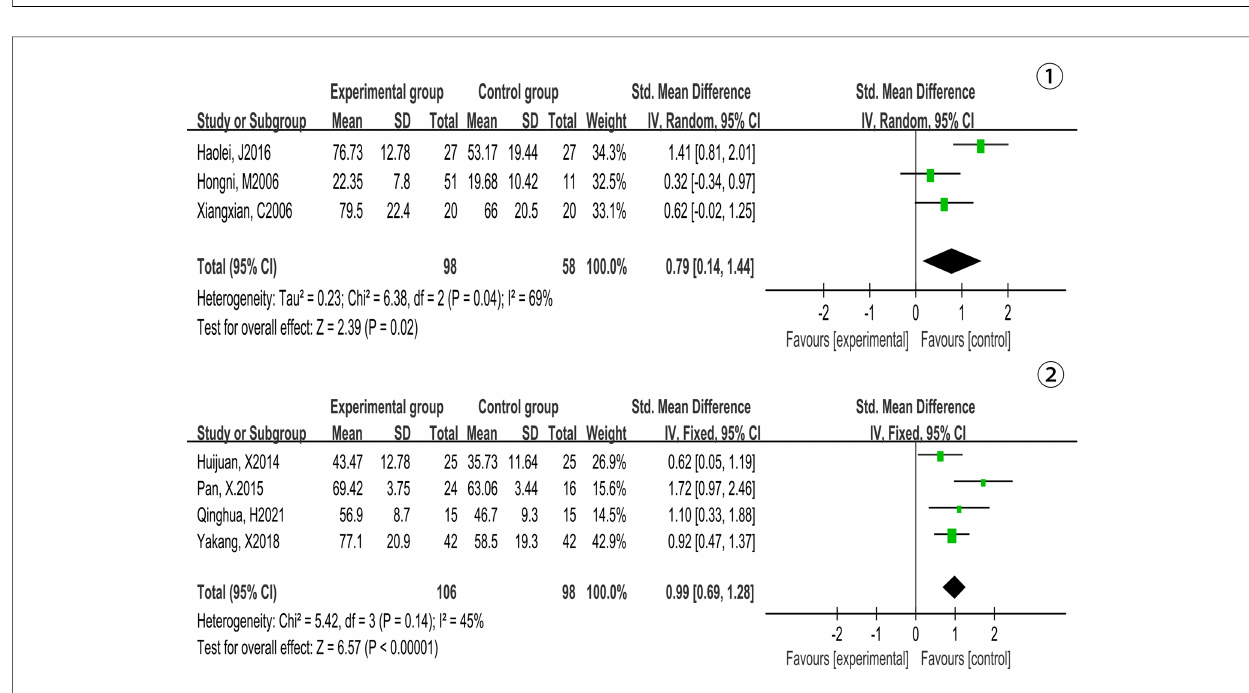
FIGURE 4 Forest plot of meta-analysis on the effect of Tai Chi exercise cycle on blood pressure (cycle ≥ 12 weeks). A , systolic blood pressure (SBP); B , diastolic blood pressure (DBP).